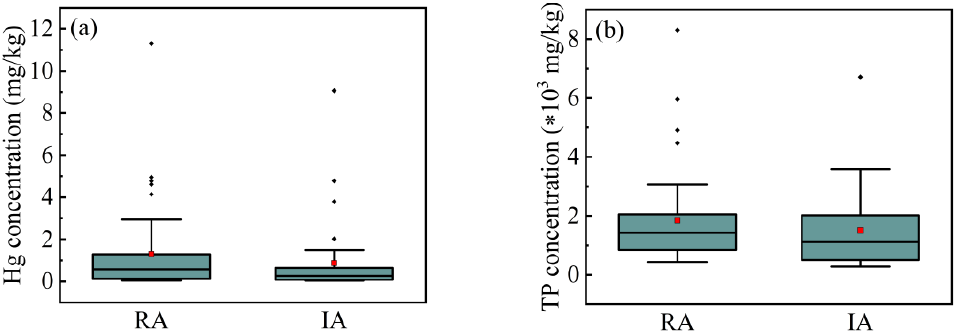
Figure 7. Box-plot of ( a ) Hg and ( b ) TP levels in different land uses. *: multiplication sign.